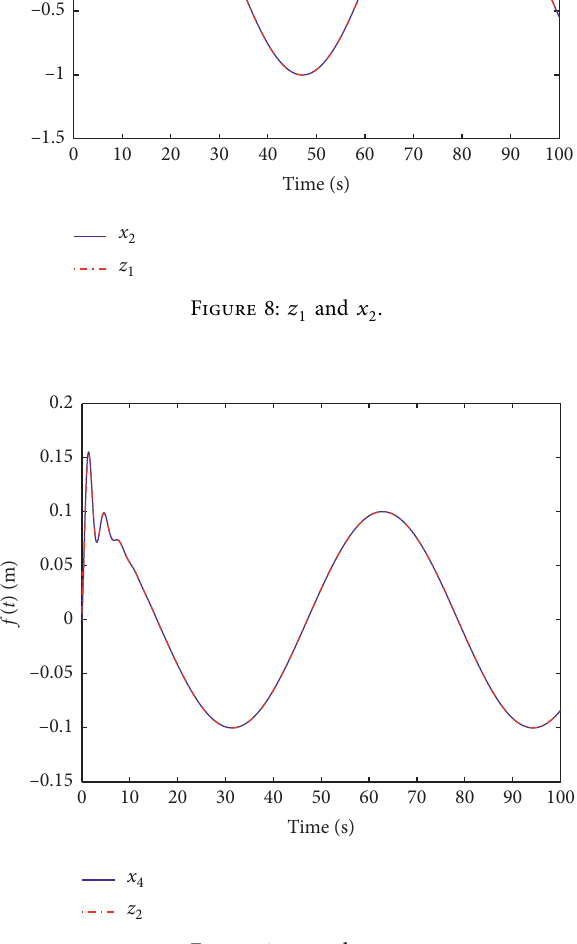
Figure 6: TD trend chart of sin ( t ) .